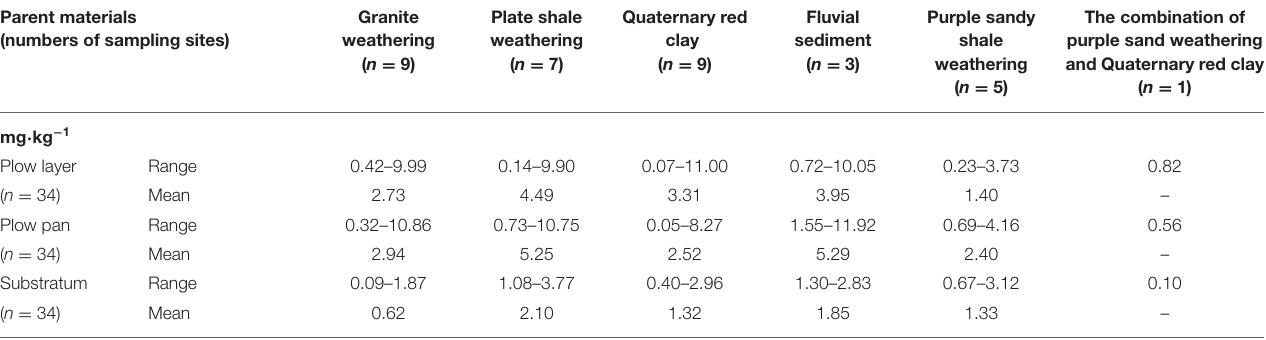
TABLE 3 | The content of Sb in paddy soil formed by different parent soils. Parent materials (numbers of sampling